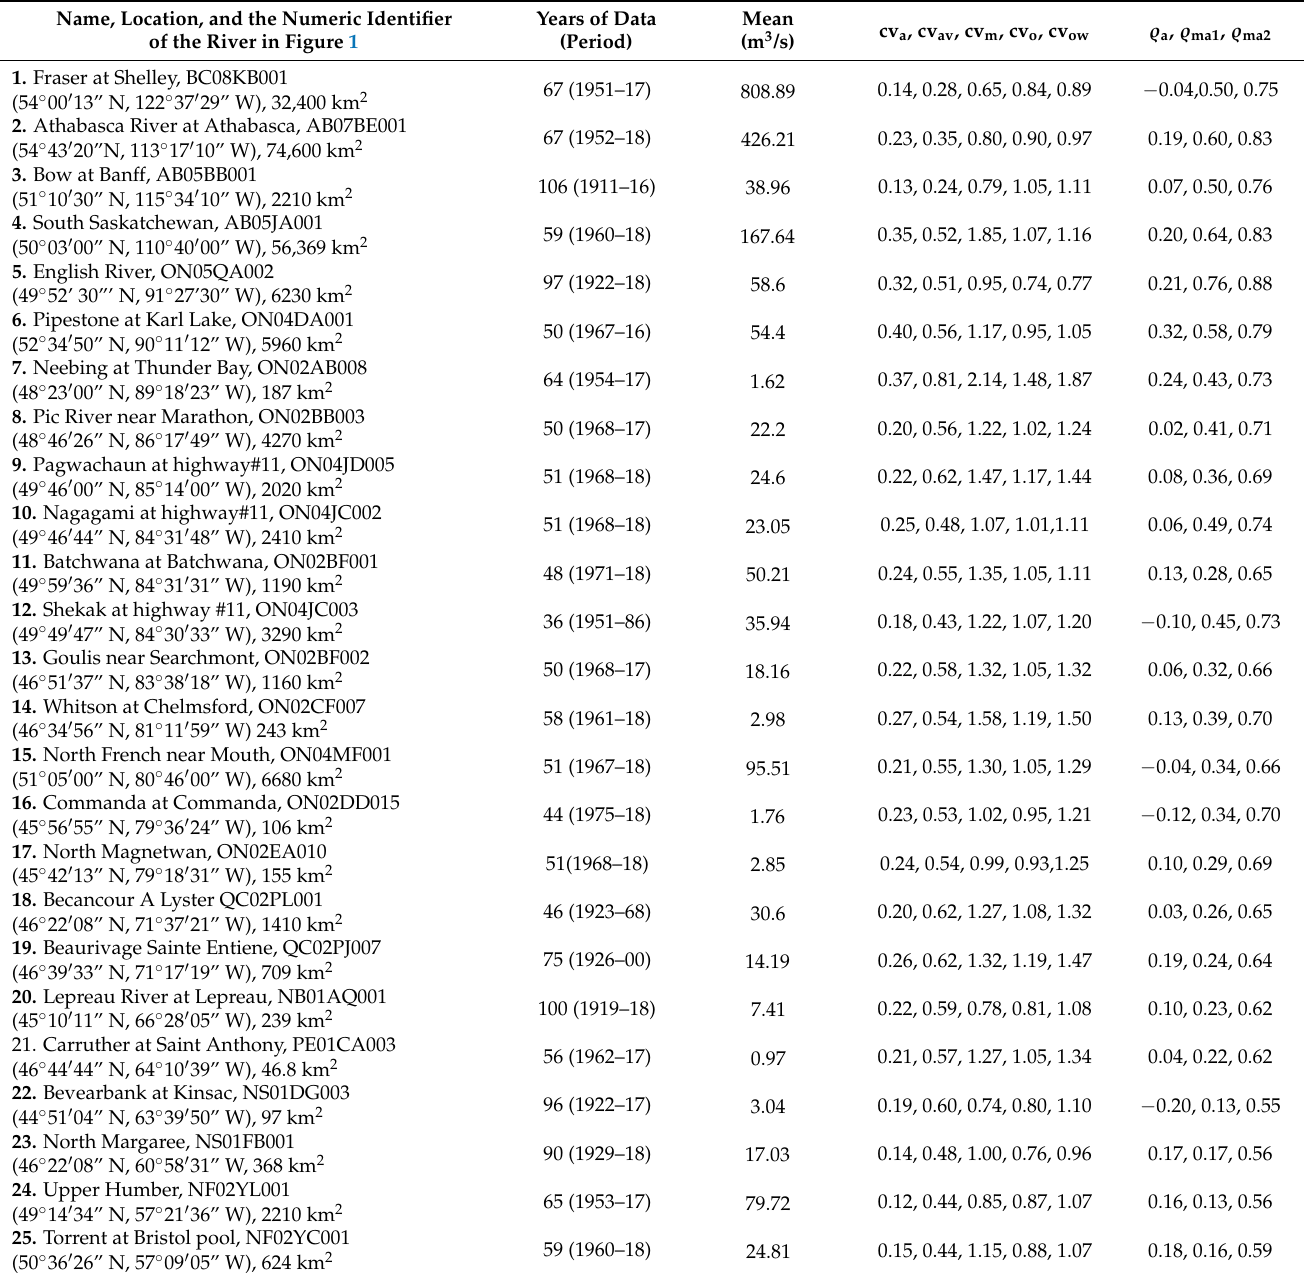
Table 2. Summary of statistical properties of annual and monthly flow sequences of the rivers across Canada used for reservoir volume